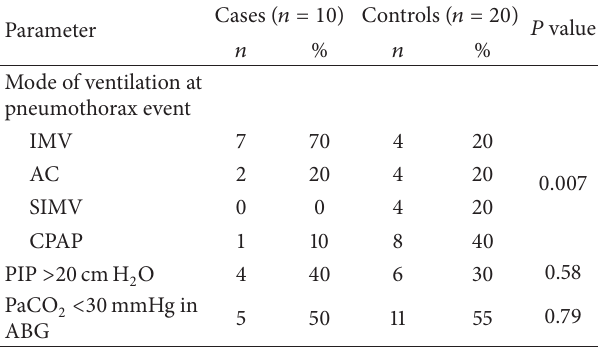
Table 1: Relationship of ventilator variables and overventilation to